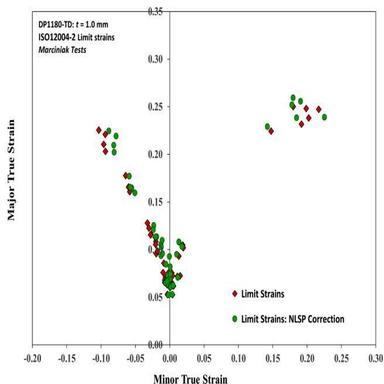
Marciniak limit strain data showing the influence of the non-linear strain path correction (NLSP).